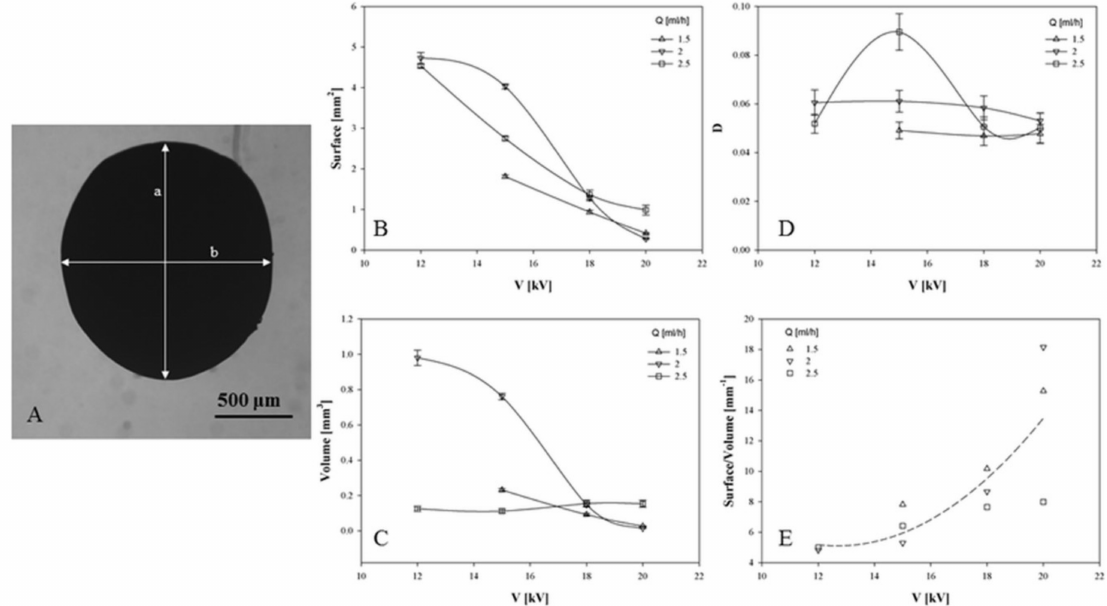
Figure 3. Detailed size and shape analysis of capsules. For each process conditions, both the axes of the ellipsoidal shaped capsules were measured ( A ). Surface ( B ) and volume ( C ) were calculated assuming an ellipsoidal shape. Particle ellipticity can be estimated by calculating the deformation parameter ( D ) and the surface/volume ratio ( E ). Each datapoint was calculated as the average of different measurements for about 80 samples, and standard error of the mean is reported as an error